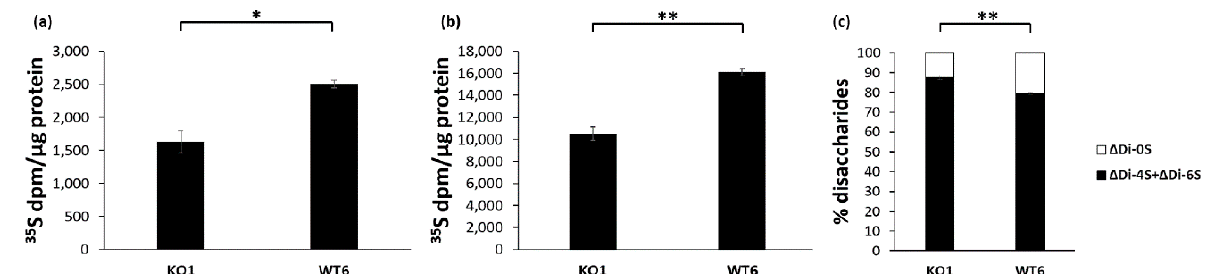
Figure 4. Cant1 knock-out chondrocytes maintained the mutant phenotype after immortalization. ( a ) Immortalized chondrocytes were metabolically labeled with 35 S-sulfate for 24 h in basal medium. The amount of newly synthesized GAGs was determined normalizing the 35 S-activity to the protein content. Data are reported as mean ± standard deviation of three experiments. Significance between KO1 and WT6 samples was analyzed by Student’s t -test; * p < 0.05. ( b ) Immortalized chondrocytes were metabolically labeled with 35 S-sulfate for 24 h in basal medium containing 1 mM p -nitrophenyl- β -D- xylopyranoside. The amount of newly synthesized GAGs was determined normalizing the 35 S-activity to the protein content. Data are reported as mean ± standard deviation of three experiments. Significance between KO1 and WT6 samples was analyzed by Student’s t -test; ** p < 0.01. In both condition, basal medium with and without p -nitrophenyl- β - D -xylopyranoside, immortalized KO1 chondrocytes synthesized less GAGs compared with immortalized WT6 cells as demonstrated previously in primary chondrocytes [33]. ( c ) Sulfation of chondroitin sulfate PGs extracted from medium of immortalized chondrocytes was analyzed by HPLC after digestion with chondroitinases ABC and ACII. Data are reported as mean ± standard deviation of three replicates. Significance between KO1 and WT6 samples was analyzed by Student’s t -test; ** p < 0.01. Immortalized KO1 chondrocytes showed a higher percentage of monosulfated disaccharides ( ∆ Di-4S + ∆ Di-6S) compared with immortalized WT6 cells as demonstrated previously in primary chondrocytes [33].